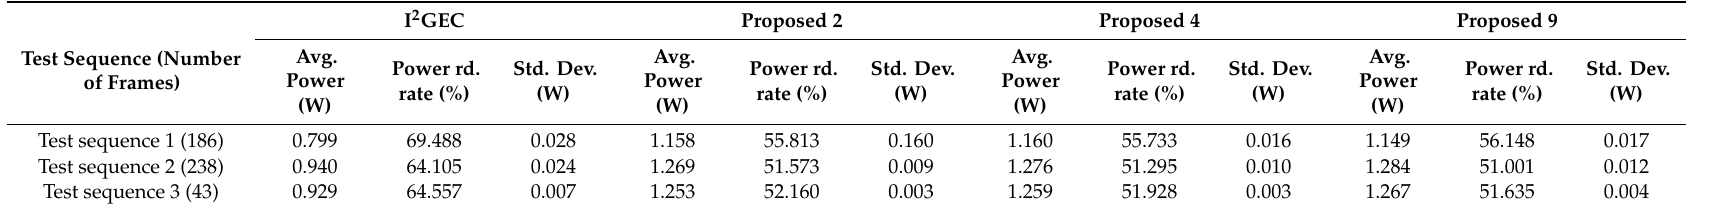
Table 2. Average power consumption and power reduction rate for the proposed and benchmark methods.